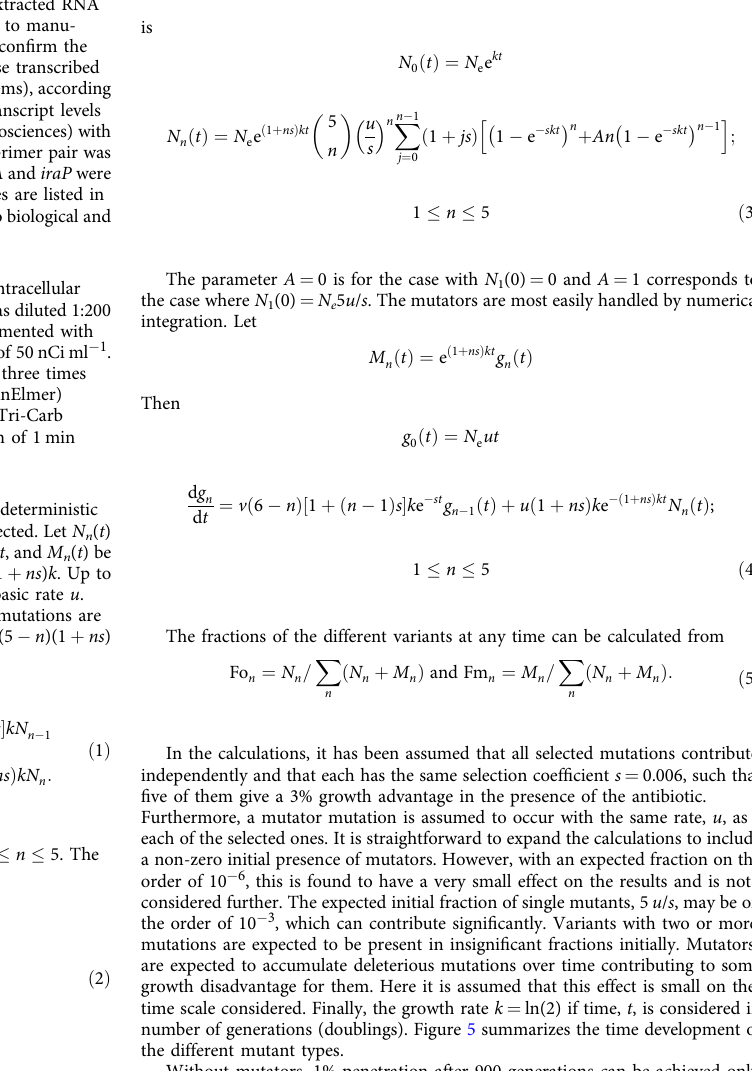
Fig. 7 Penetration of mutants with fi ve selected mutations. Penetration after 900 generations as a function of mutator mutation rate v for values of u between 5 × 10 − 7 (black curve on the right) and 4 × 10 − 6 (red curve on the